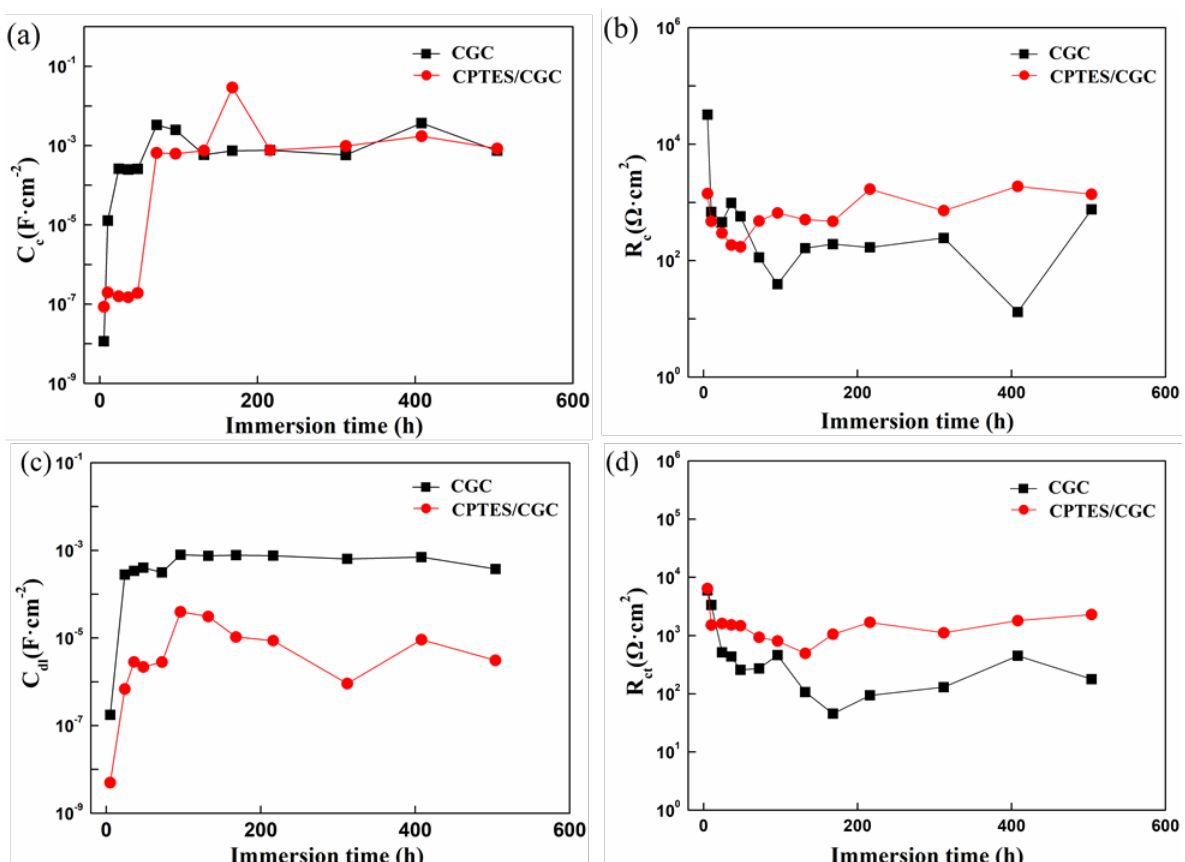
Figure 11. Evolution of ( a ) coatings capacitance, ( b ) charge transfer resistance, ( c ) double layer capacitance, and ( d ) charge transfer resistance with immersion time.